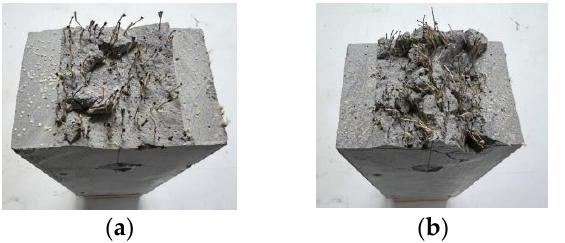
Figure 6. Examples of the visual appearance of fracture surface: ( a ) Fc36-1%; ( b ) Fc36-2%.